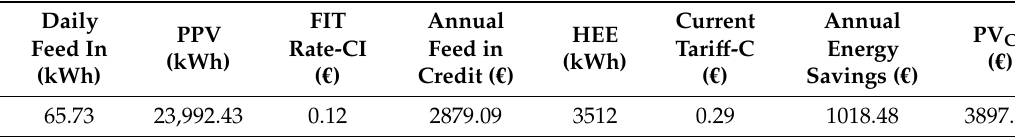
Table 3. Photovoltaic plant installation (Germany).